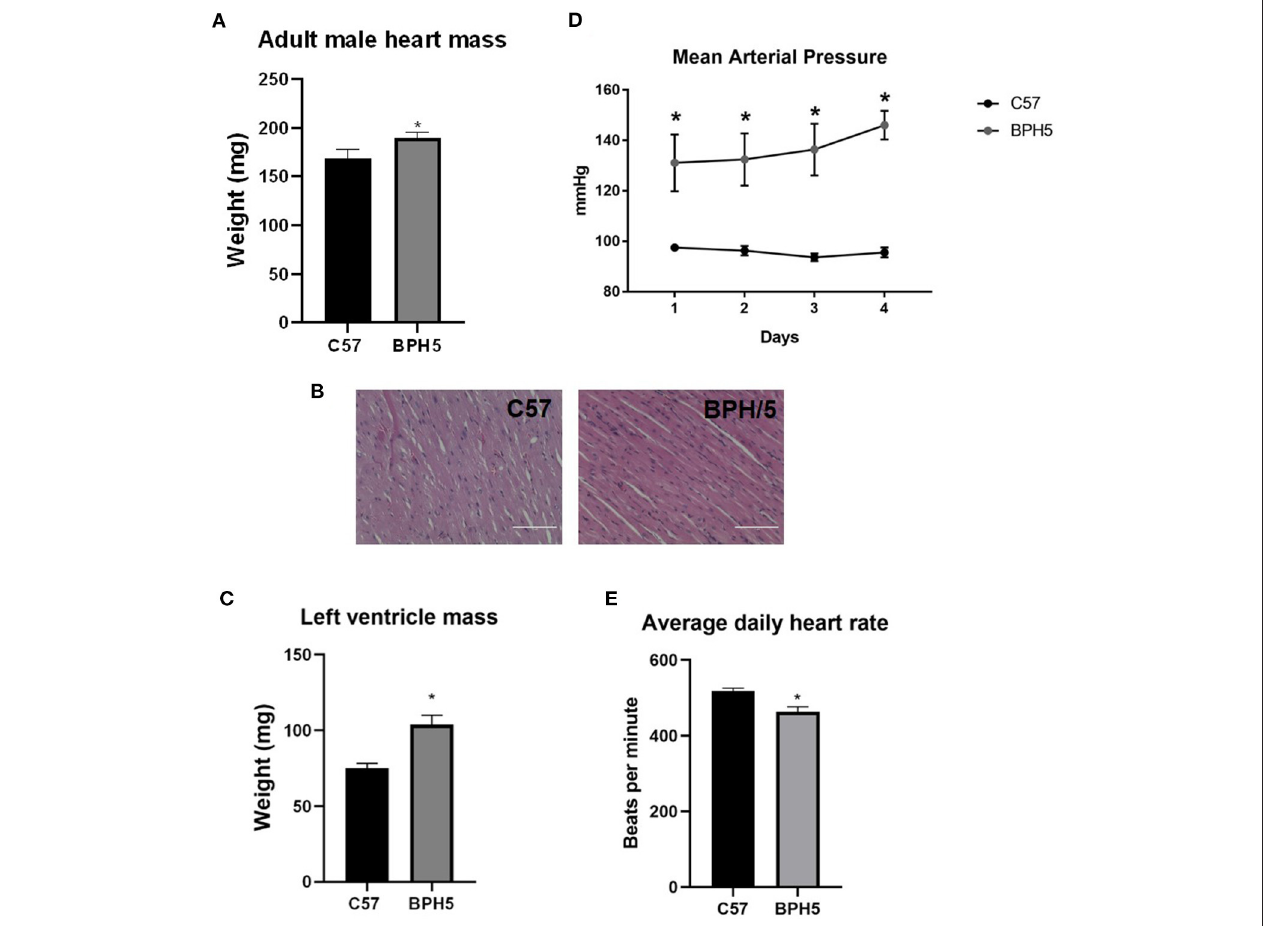
FIGURE 2 | Adult BPH/5 male mice exhibit signs of cardiovascular disease. (A) BPH5 male mice demonstrate increased heart mass compared to C57 controls. (B) Hematoxylin and eosin (H&E) stain of C57 (left) and BPH/5 (right) cardiac tissue. Scale bar = 100 µ m. (C) BPH5 male mice demonstrate increased mass of the left ventricle compared to C57 controls. (D) BPH5 male mice demonstrate increased mean arterial pressure compared to C57 controls as measured over 4 consecutive days. (E) Daily average heart rates measured as beats per min were increased in BPH/5 adult males compared to C57 ( n = 4–18/group; * p < 0.05 vs. C57).